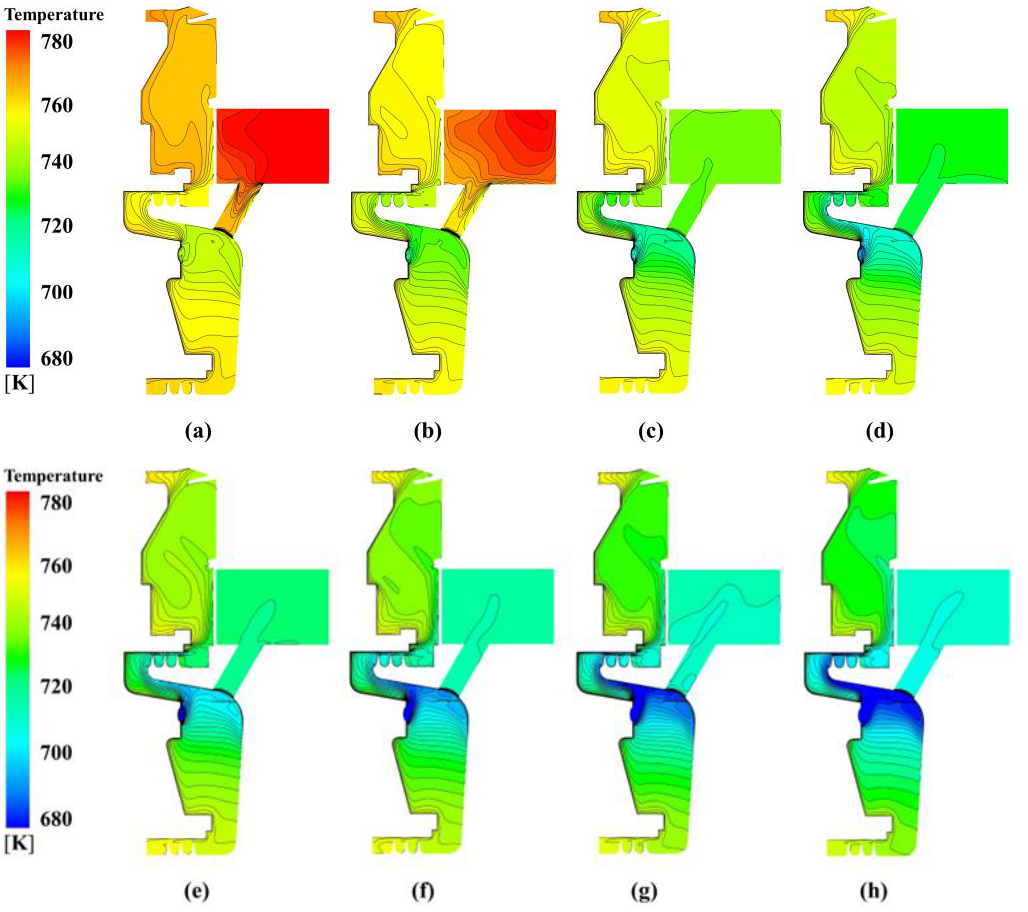
Figure 15. Temperature distribution of pre-swirl cavity at Re = 9.5172 × 10 5 with different nozzle pressure: ( a ) −30 % design pressure, ( b ) −20 % design pressure, ( c ) −10 % design pressure, ( d ) design pressure, ( e ) +10% design pressure, ( f ) +20% design pressure, ( g ) +30% design pressure, and ( h ) +40% design pressure.